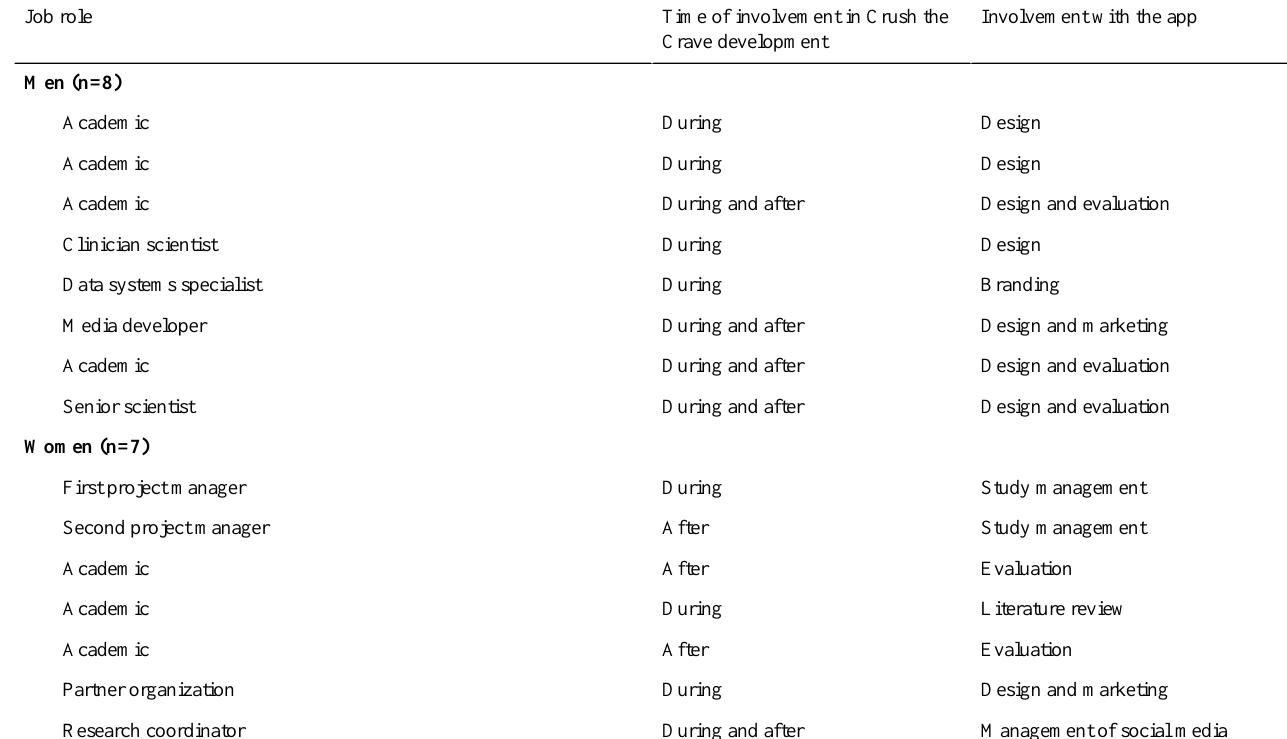
Table 1. Key informant sample. developmentJob